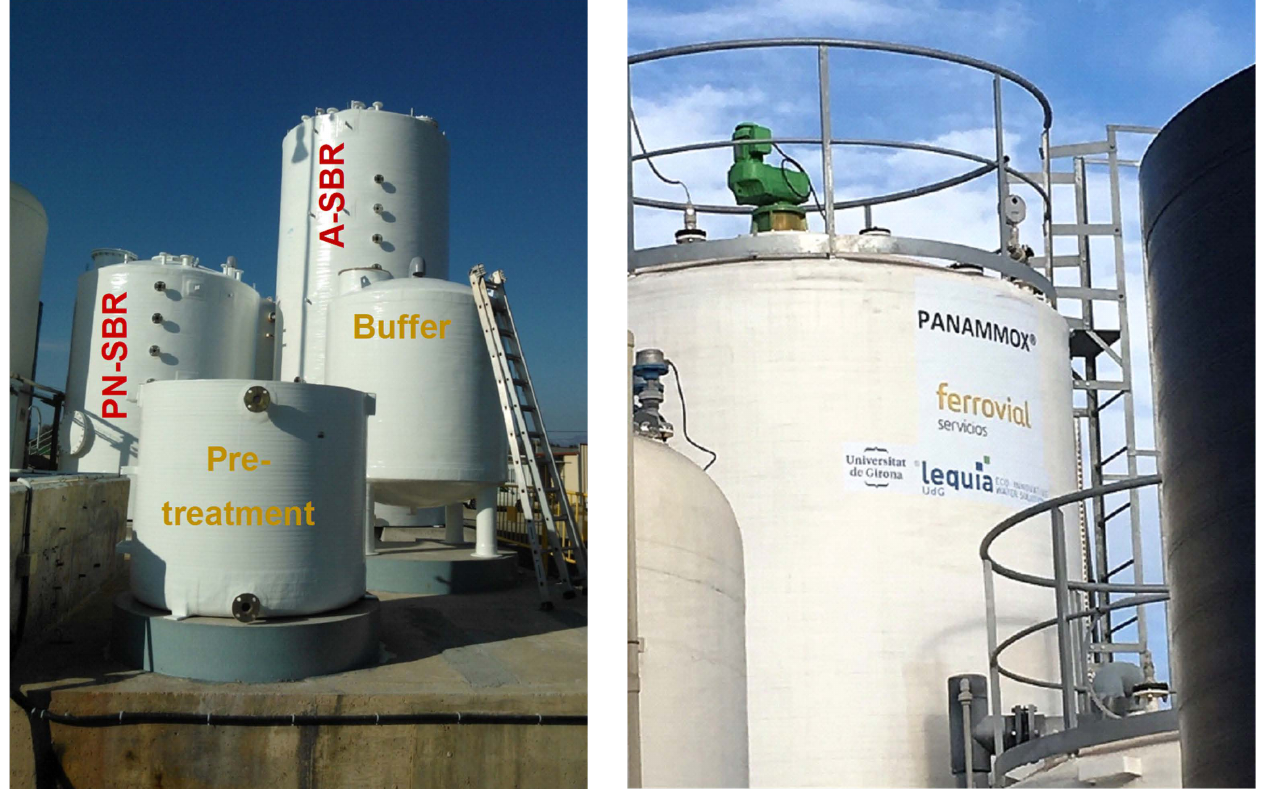
Figure 2. Views of the PANAMMOX ® system running at the CORSA landfill